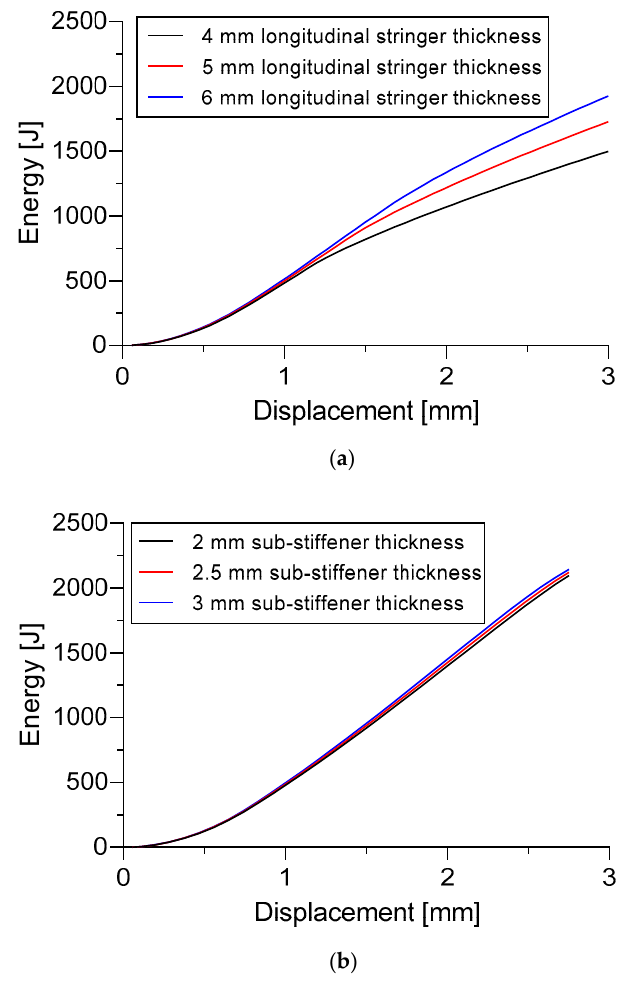
Figure 23. Effect of stiffeners thickness to the energy versus displacement curve. ( a ) Specimen A; ( b ) Specimen